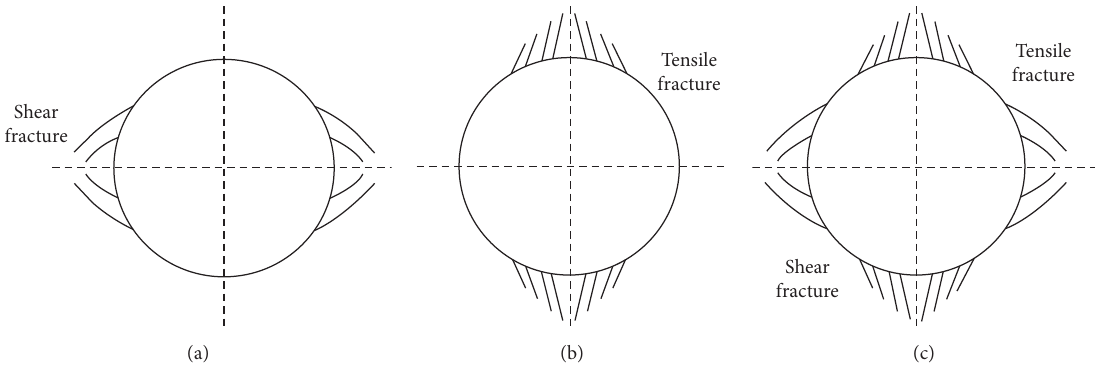
Figure 4: Final fracture patterns: (a) shear fractures, (b) tensile fractures, and (c) coexistence of shear and tensile fractures.